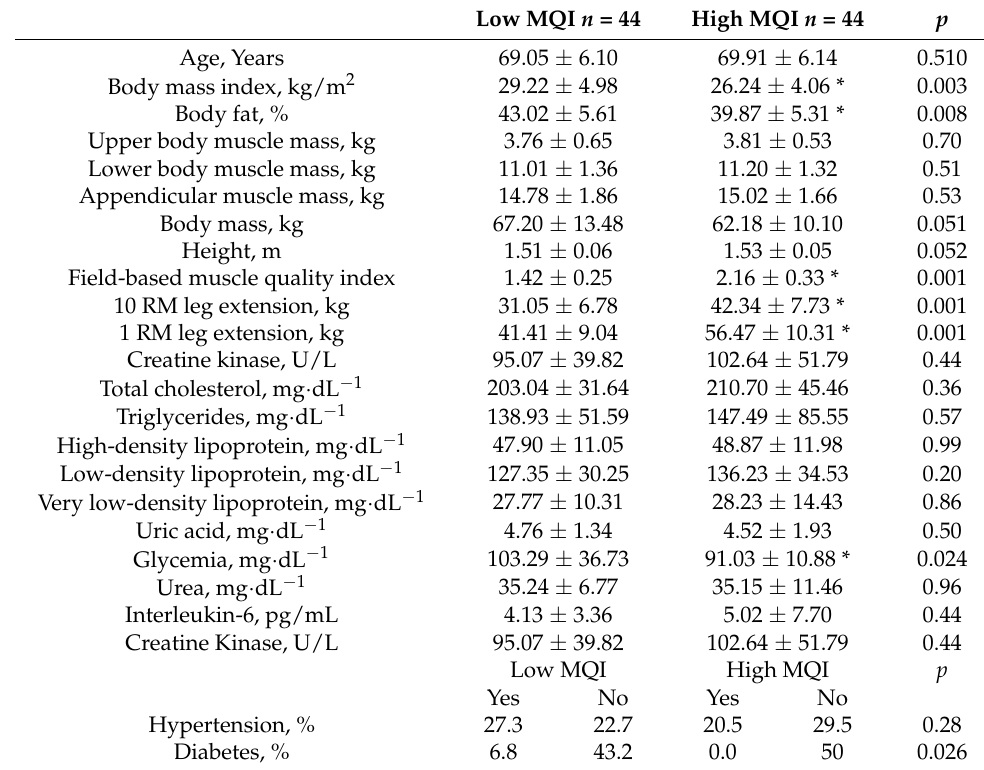
Table 2. Field muscle quality participant